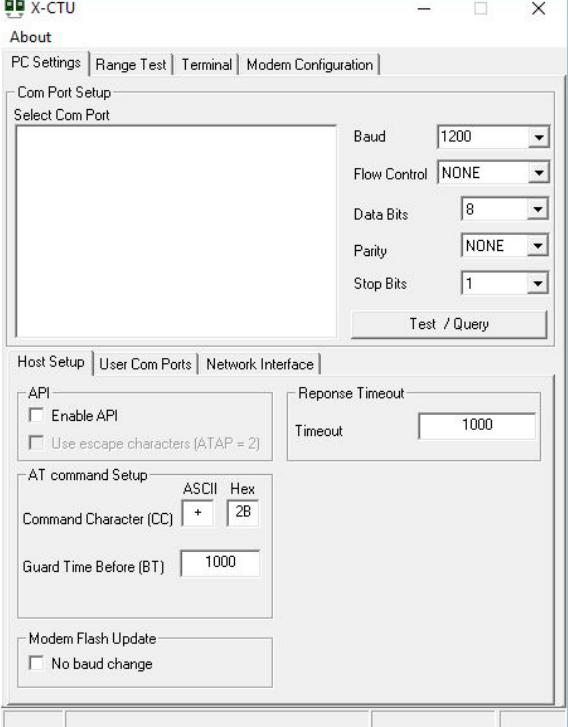
Figure 9. XCTU terminal.